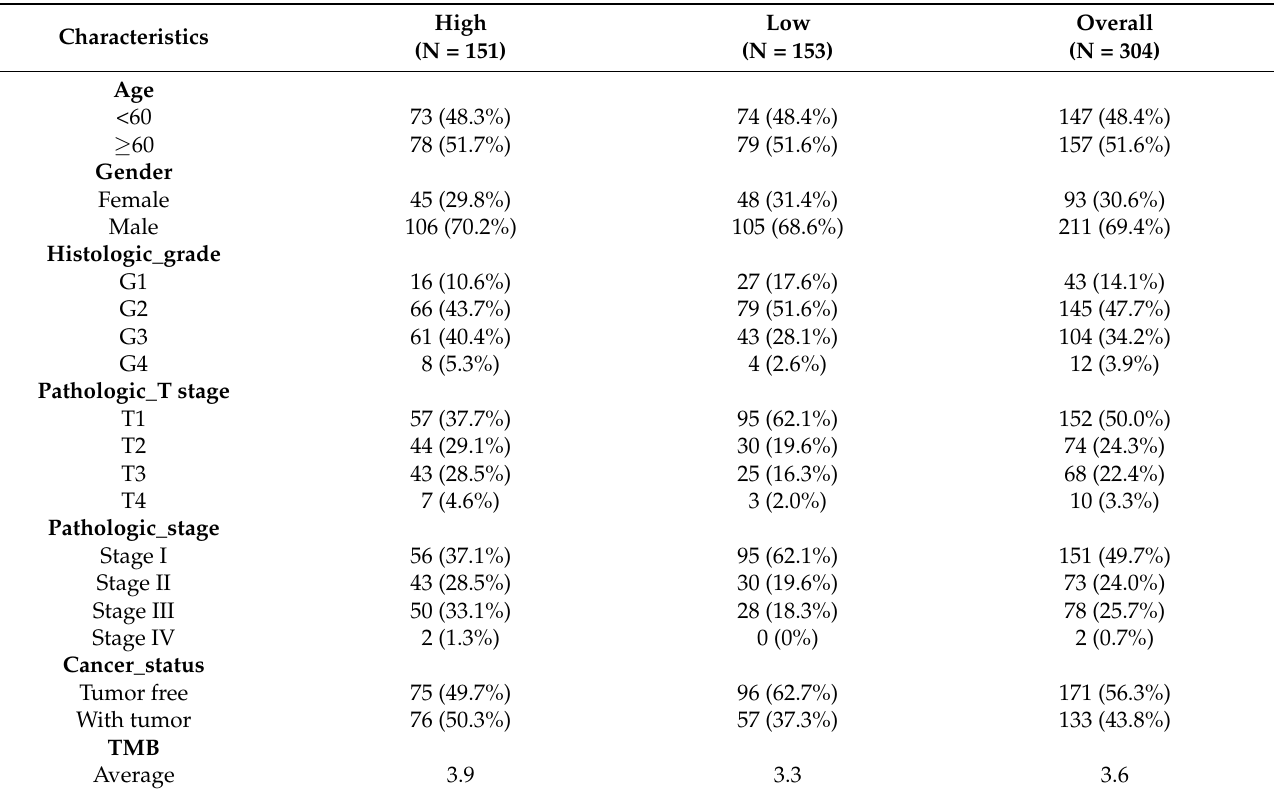
Figure 7. Comparison of genomic mutations between the CSIRG high-risk group ( A ) and the CSIRG low-risk group ( B ) of the TCGA-LIHC dataset. Table 1. Clinical information for TCGA cohort.